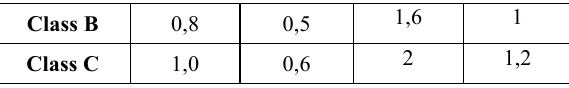
Table 1: PEC planimetric thresholds for 1:2,000 scale.